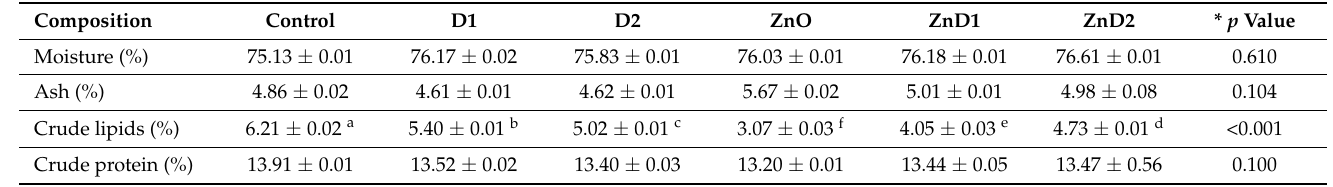
Table 4. Whole body composition (% wet weight basis).